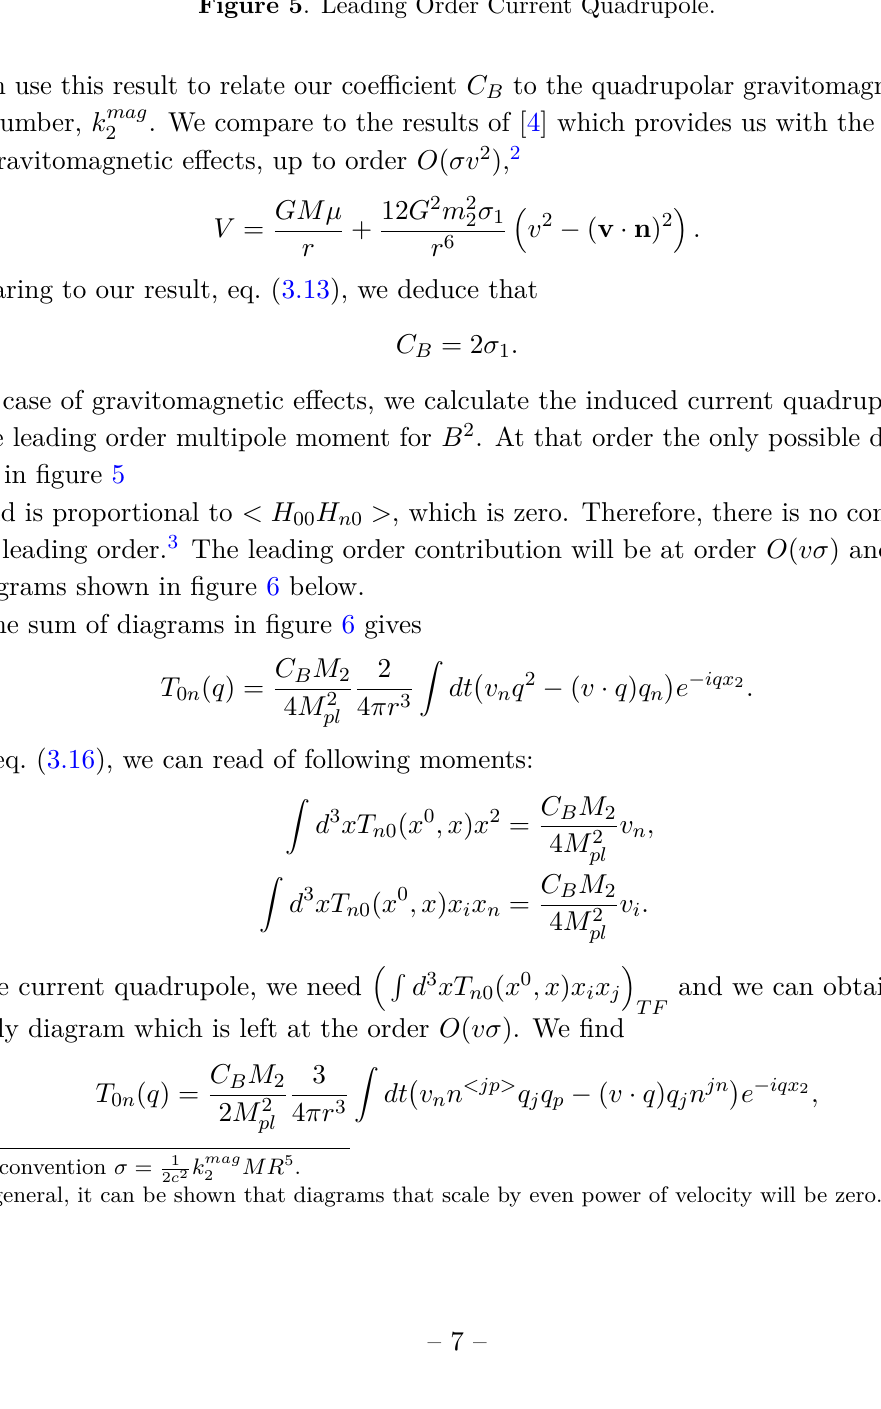
Figure 5 . Leading Order Current